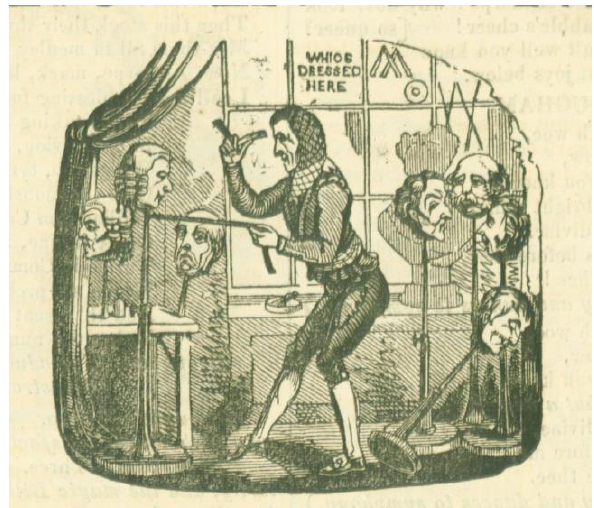
Fig. 7 The famous wood-engraved masthead produced by Seymour for Figaro in London and used by the magazine between 1831 and 1839 despite the block developing a clearly visible